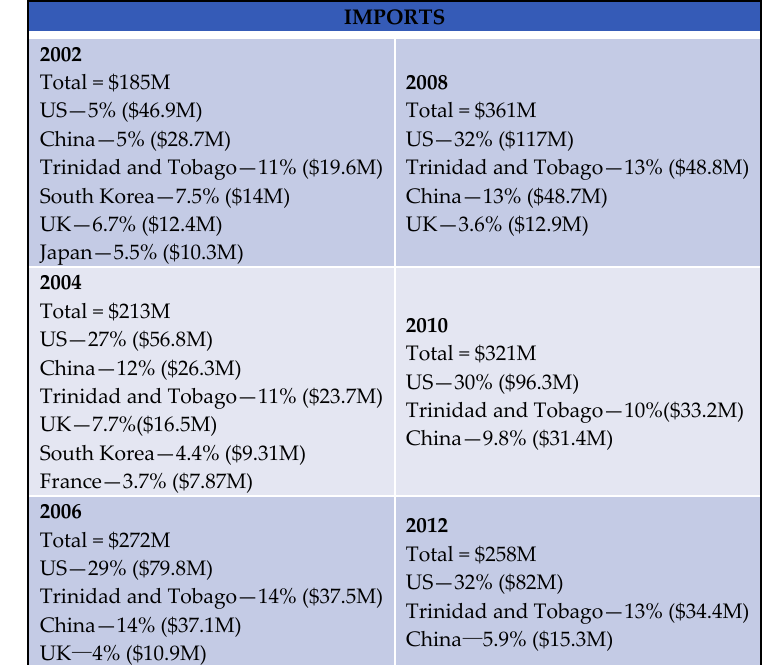
Table 4. Percent Share of Top Export Partners. Table 3. Percent Share of Top Import